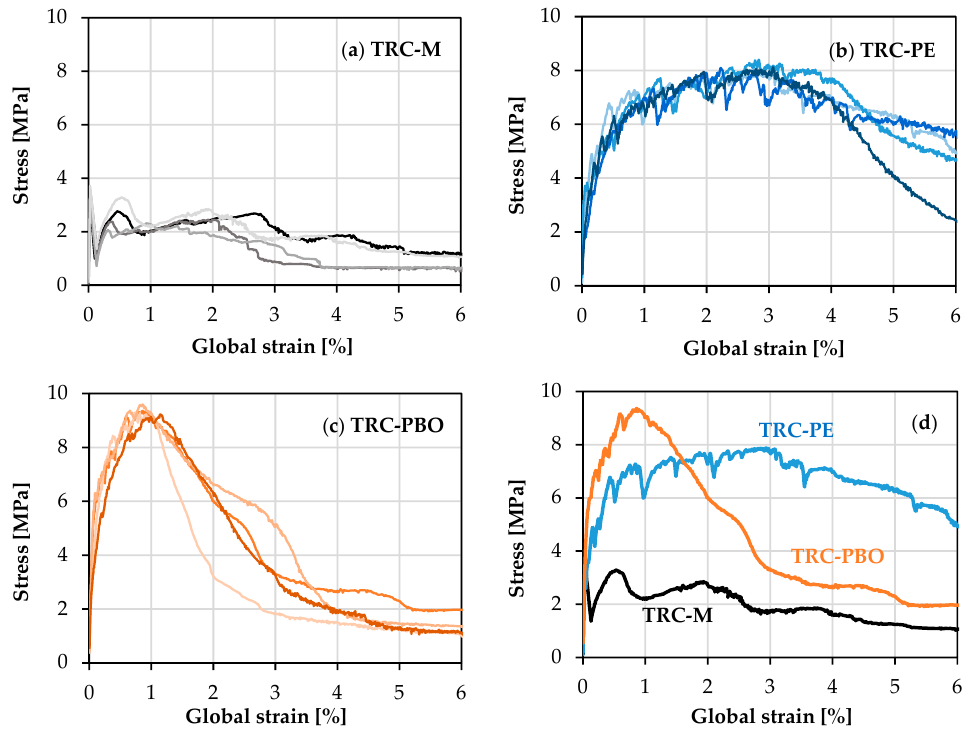
Figure 7. ( a – c ) Tensile stress–strain curves of the composites under quasi-static loading and ( d ) representative stress–strain relationships for the composites under investigation.